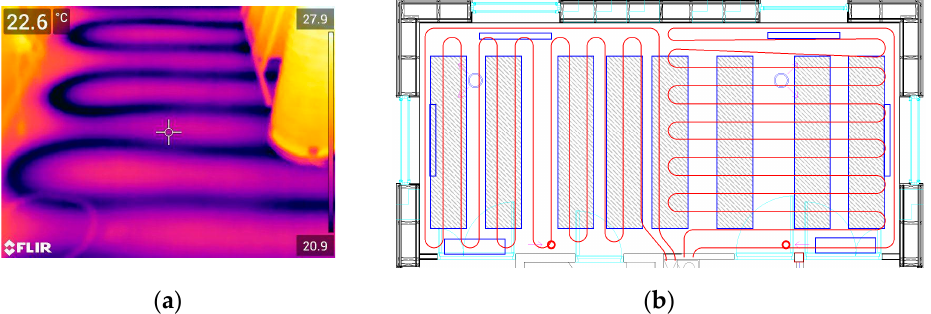
Figure 8 . Thermographic image of the underfloor piping ( a ) and piping positioning layout ( b ).